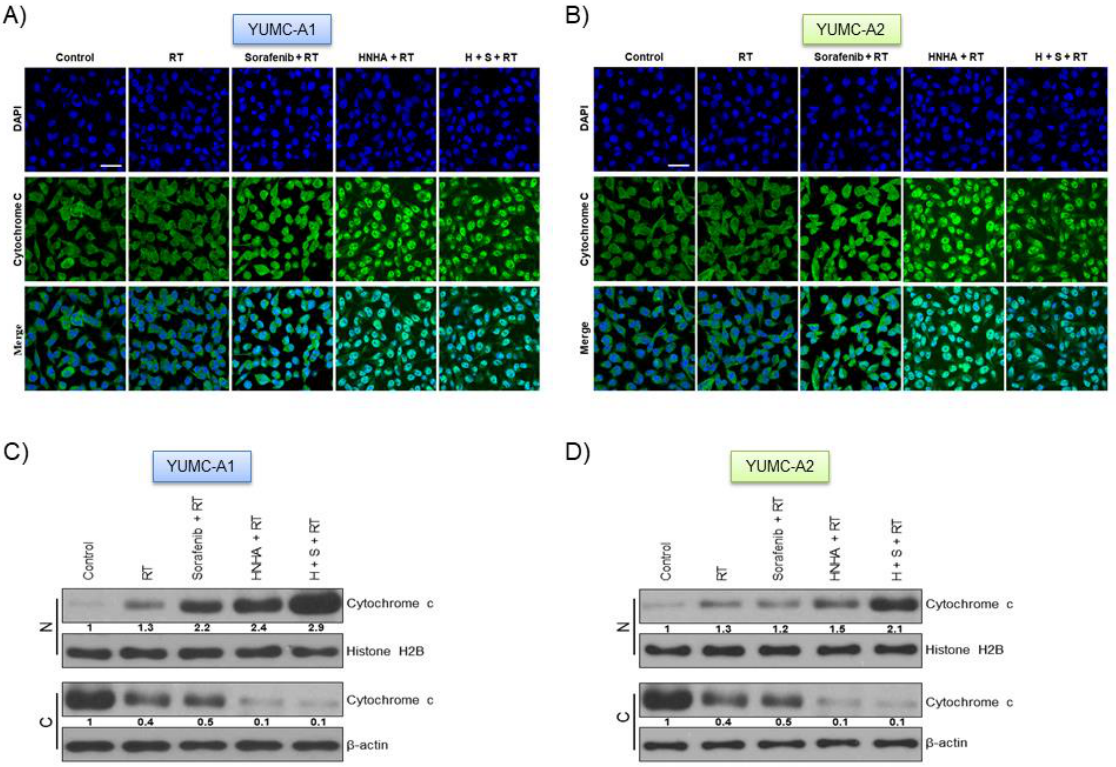
Figure 5. Synergistic anticancer effect of HNHA, sorafenib, and radiation was most induced nuclear-translocatyion of the cytochrome c on patient-derived ATC cell lines. Immunofluorescence ( A , B ) examined at × 400 magnification; scale bar, 20 μm and subcellular fractionation ( C , D ) analysis. Cytochrome c was most translocated and accumulated in the nucleus by HNHA, sorafenib, and radiation treatment group on patient-derived ATC cell lines: ( A , C ) YUMC-A1 and ( B , D )